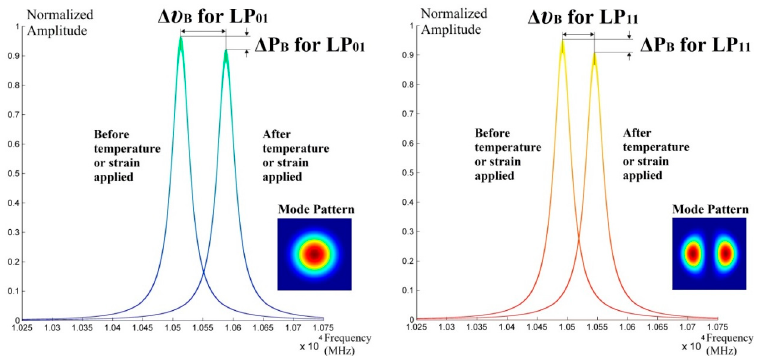
Figure 8. Brillouin Gain Spectra for LP 01/11 modes in FMF.